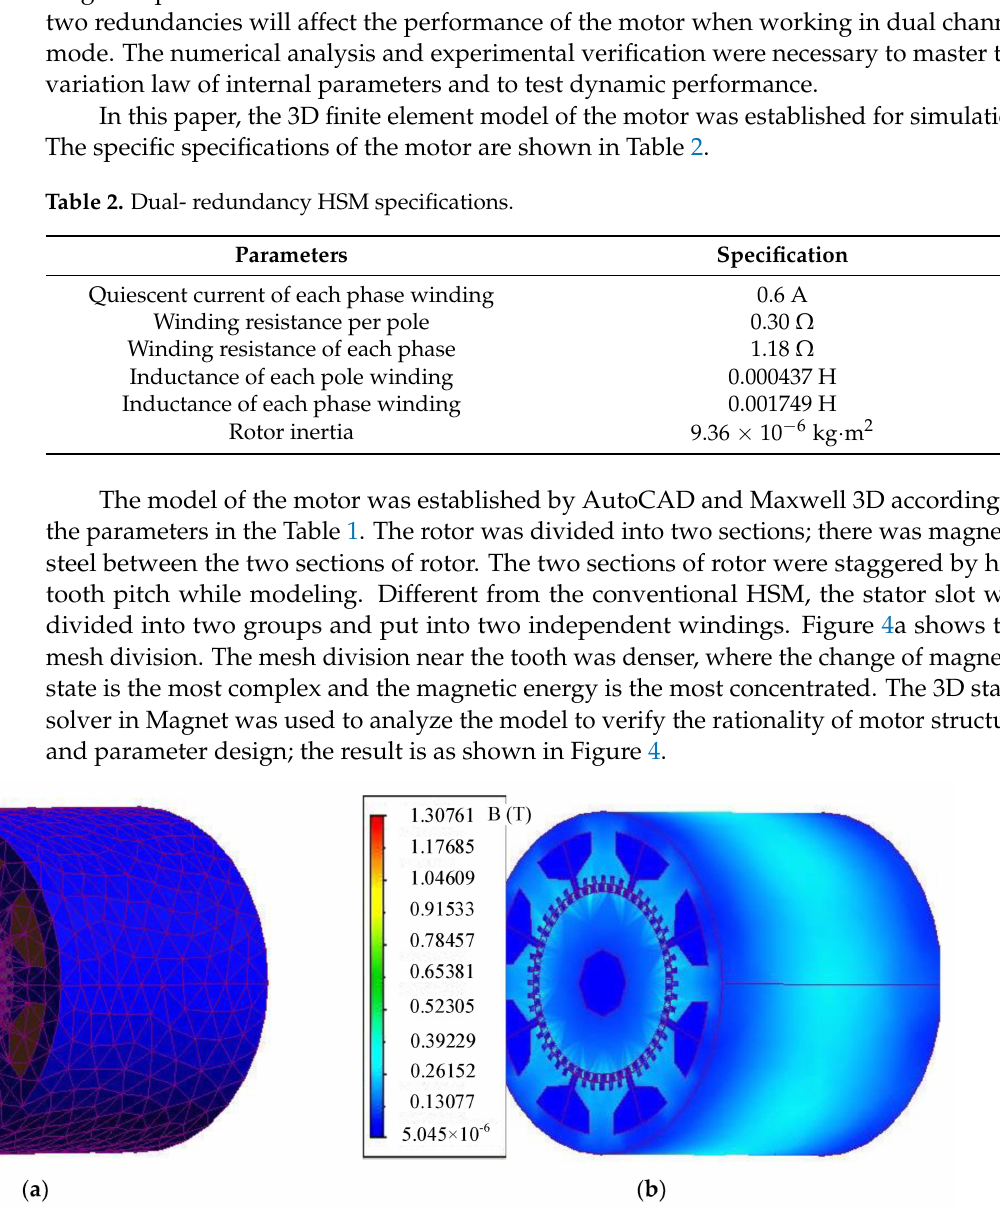
Figure 5. Magnetic flux density distribution of the rotor. ( a ) 3D magnetic flux density distribution of the rotor. ( b ) Magnetic flux density distribution of the rotor cross section . Figure 6 shows the flux density distribution in the air gap; the magnetic density reached the maximum value when the teeth of stator and the teeth of the rotor were aligned. The peak value of the air-gap flux density exhibited appropriate value, with nearly 0.6 T to 0.7 T. Figure 7 shows the flux density distribution of the tooth. It can be seen that the magnetic field distribution of the motor is reasonable. F l ux d e n s it y ( T ) 0.10.8 0.7 0.6 0.5 0.4 0.3 0.20.9 Position(degree) 0 5 5010 656055452520 3015 35 40 100959085807570 Figure 6. Magnetic flux density of the air gap.